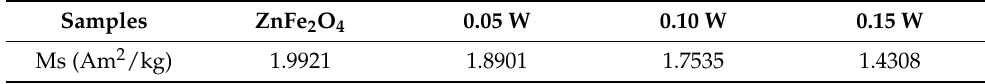
Table 3. The magnetization of the ZnW x Fe 2 − 2x O 4 samples at 20